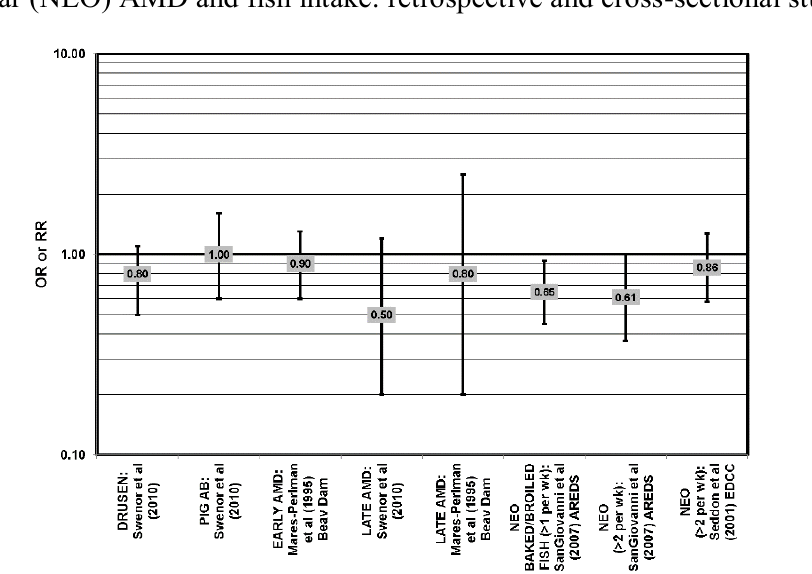
Figure 13. Relationship between early indicators of AMD (DRUSEN, PIG AB), early, late or neovascular (NEO) AMD and fish intake: retrospective and cross-sectional